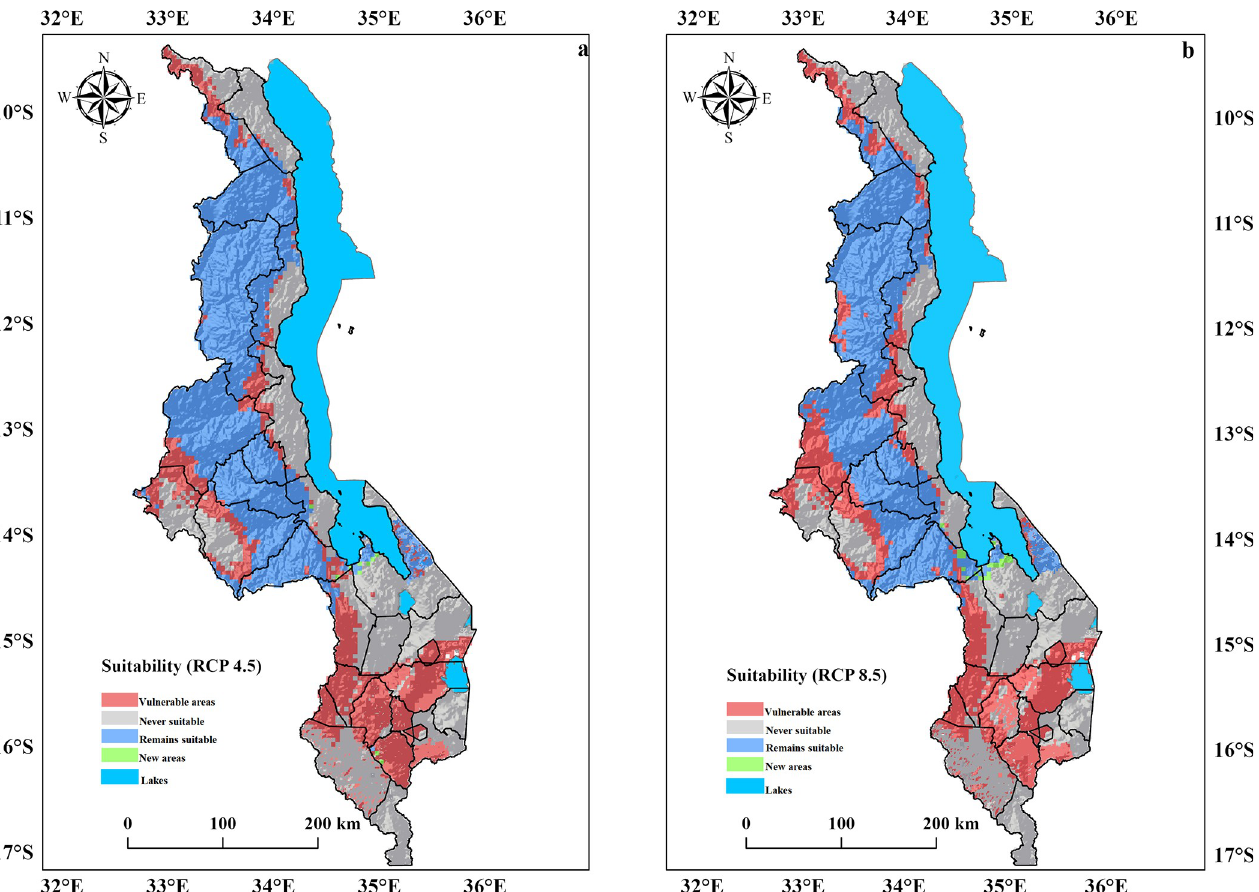
Fig 6. Shifts in macadamia suitability due to climate change by 2050 (a) RCP 4.5 (b) RCP 8.5. The model results were exported into Arc GIS Pro Software Version 2.5 to generate the map in this figure.